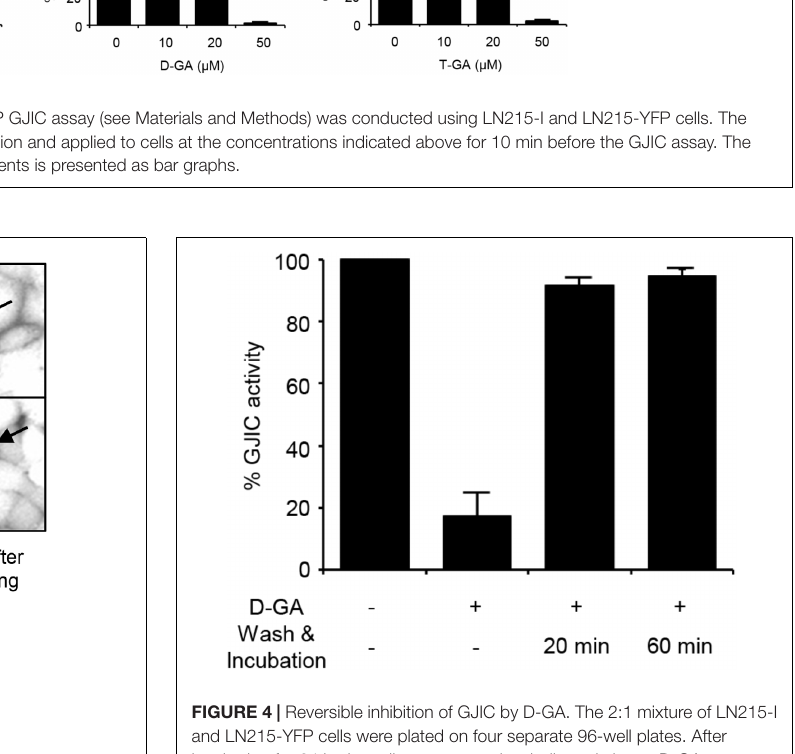
was considered to indicate a statistically significant difference. To obtain the IC50, log [compound], and % GJIC inhibition values were fitted into the log [inhibitor] vs. normalized response – variable slope equation.